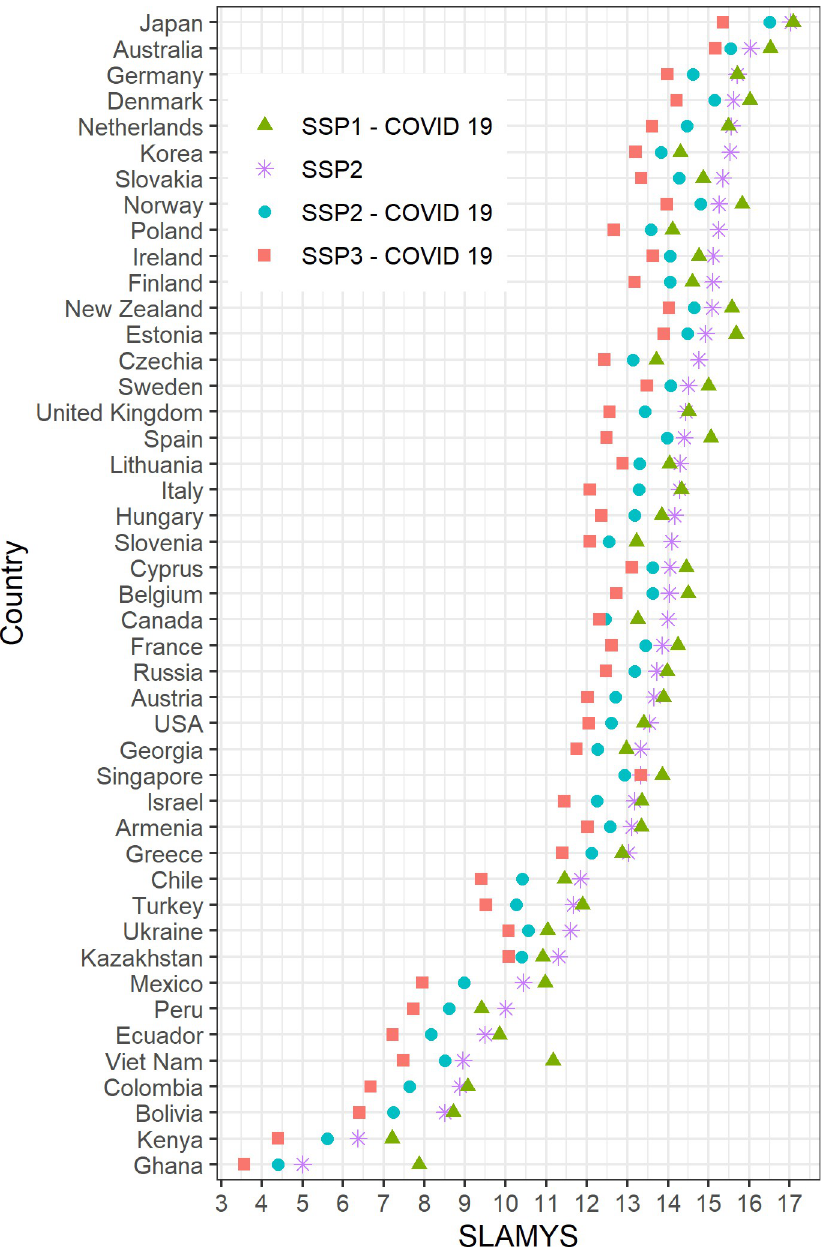
Fig 4. Projection of SLAMYS, 40–44 year-olds, several scenarios, 2050. Source: Authors’ calculations. Note: Data sorted by projected SLAMYS according to SSP2 scenario.